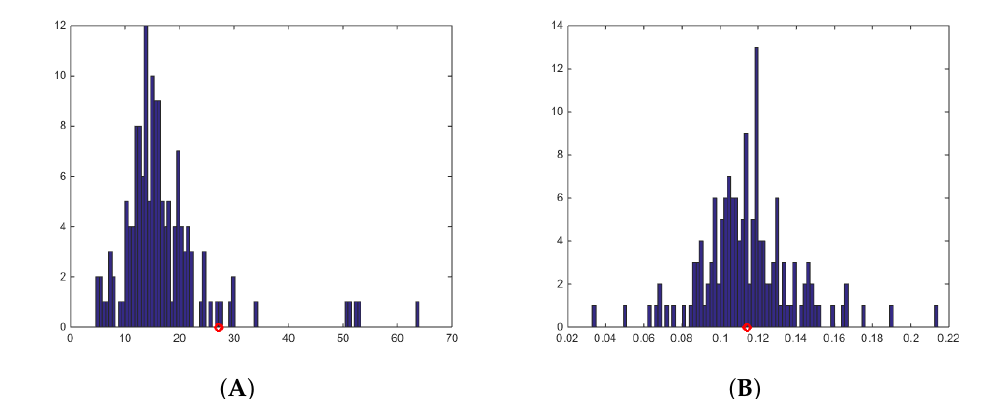
Figure 2. Distributions of errors for expert economic predictions between 1996 and 2016, appearing in the Fairfax Business Day survey of economists: ( A ) SMdAPE, and ( B ) ALRE. The Australian Treasury forecasts are indicated by the red